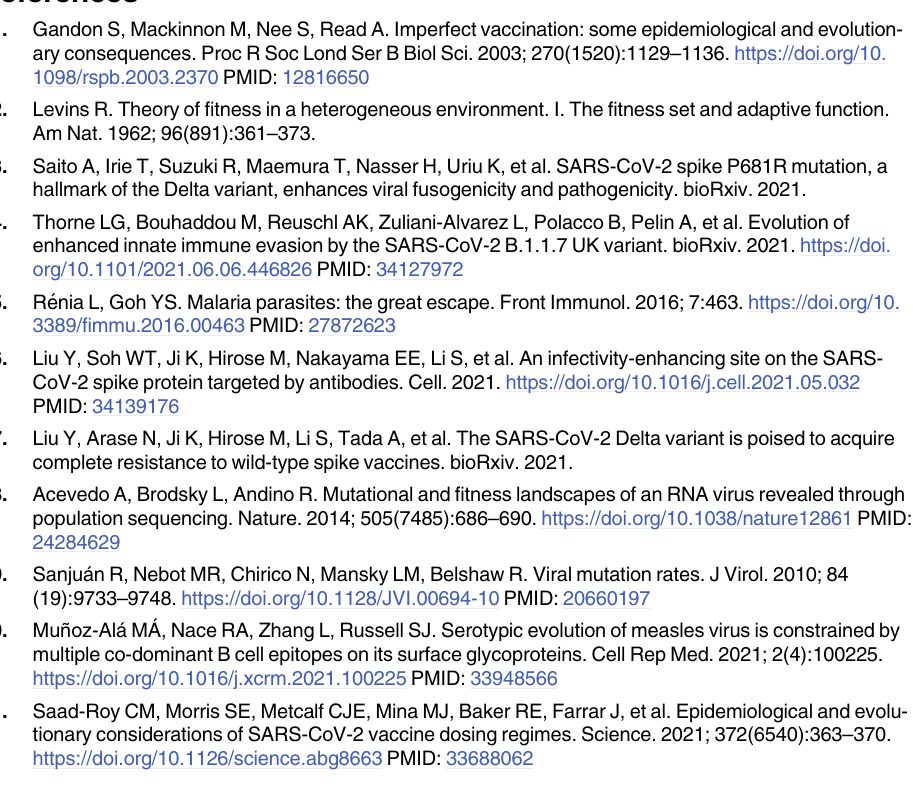
S1 Fig. Typology of pathogen variants. We can identify 8 different types of variants. The panel (a) is expanding the description of Fig 2 and the panel (b) is indicating the location of these 8 types. Variant type I is adapted to na ï ve hosts but maladapted on primed hosts. Variant type V is maladapted on both types of hosts. We focus on the 6 immunity-adapted variants with Δ r > 0. Variants II, III, and IV are generalist variants (i.e., r > 0) and the magnitude of P i,N explains the difference between these 3 variants. Variants VI, VII, and VIII are specialist Δ r P variants (i.e., Δ r < 0) and the magnitude explains the difference between these 3 variants. Note N that variants IV, VII, and VIII have a growth rate that increases with the fraction of hosts primed. This increased growth rate can have major public health implications. In particular, with variants IV and VIII, evolution is expected to yield a higher pathogen growth rate after 100% primed (the evolved growth rate r is indicated with the black dot) than after 0% primed i,P (the evolved growth rate r indicated with the white i,N